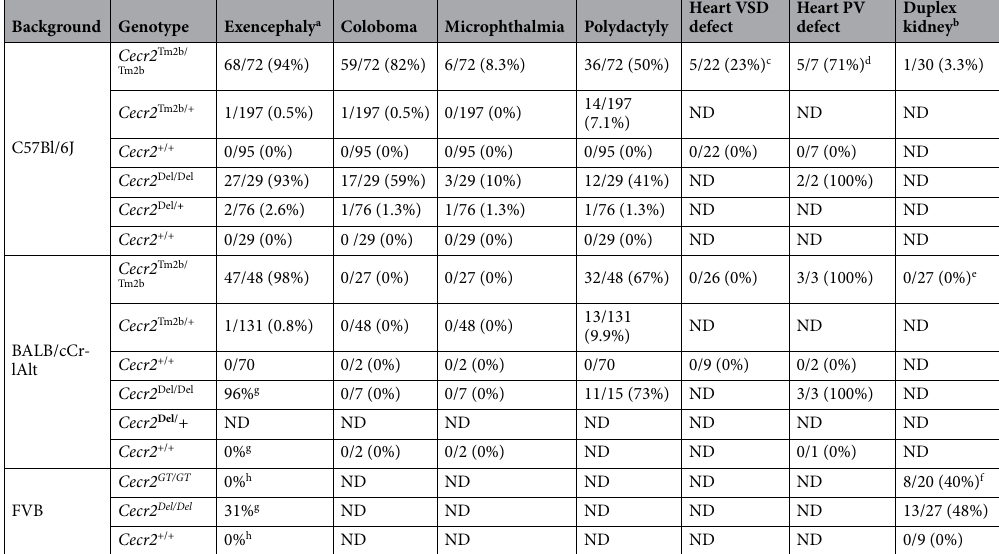
Table 1. Penetrance of defects in late stage embryos, with 3 different Cecr2 mutations on 3 different genetic backgrounds. Numbers represents the number of embryos (ND = not done). a Exencephaly penetrance applies only to the coloboma/micropthalmia/polydactyly datasets. b At least one duplex kidney present in the embryo. c In addition 2/22 showed hypoplastic RV, which was not seen in wildtype controls. d 1/7 showed a defect of the great vessels, and 2/7 showed abnormal vessels from the right lung to the RSVC. e 1/27 had one kidney with a central cavity which may have been hydronephrotic and duplex. f 168 adults were also examined: 16 (9.5%) had unilateral agenesis, 3 (1.7%) had hydronephrosis. g Fairbridge et al., 2010. h Banting et al.,